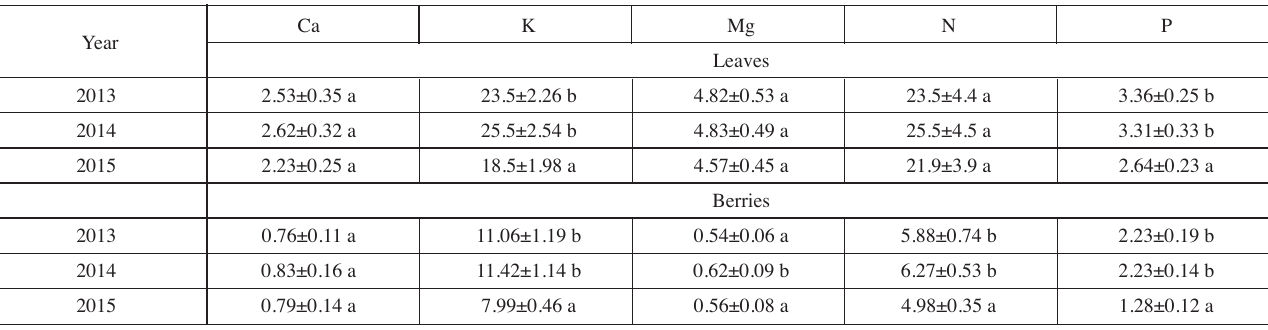
Tab. 2: The average of macronutrient composition (g/kg) in leaves and berries of ‘Regent’ during three years of study (2013-2015) from the own-rooted and grafted vines Ca